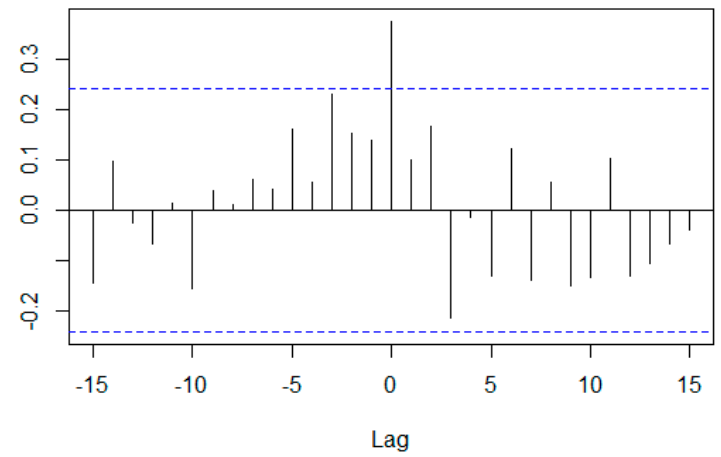
Figure 19. Cross-correlation coefficient between the average BHAR of the whole sample group and the average BHAR of the camera group for Jan 2013–Jul 2018.